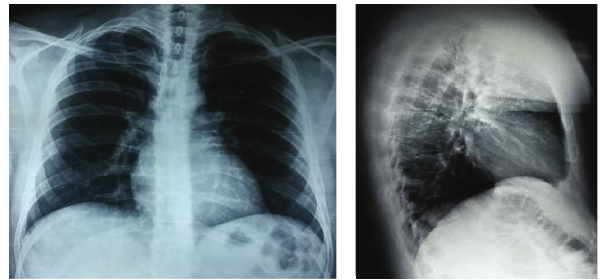
Figure 1: Posteroanterior and lateral chest X-rays of the patient.